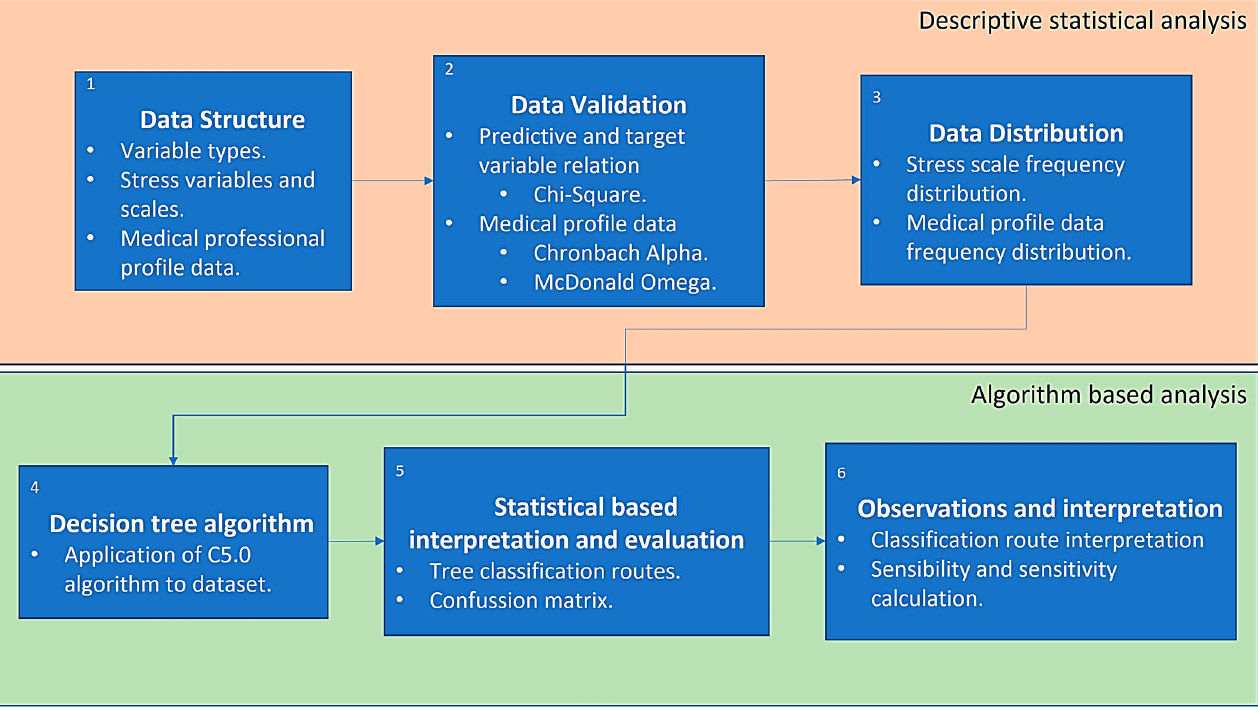
Figure 1. Methods for machine learning-based analysis on stress scales of healthcare workers.